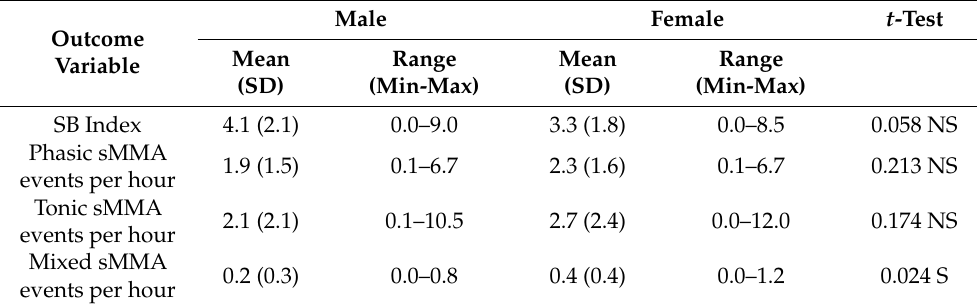
Table 4. Descriptive statistics pertaining to the variables for male and female (mean value, standard deviation, range) and differences between gender assessed using Student’s t-test for each variable (statistical significance: p <